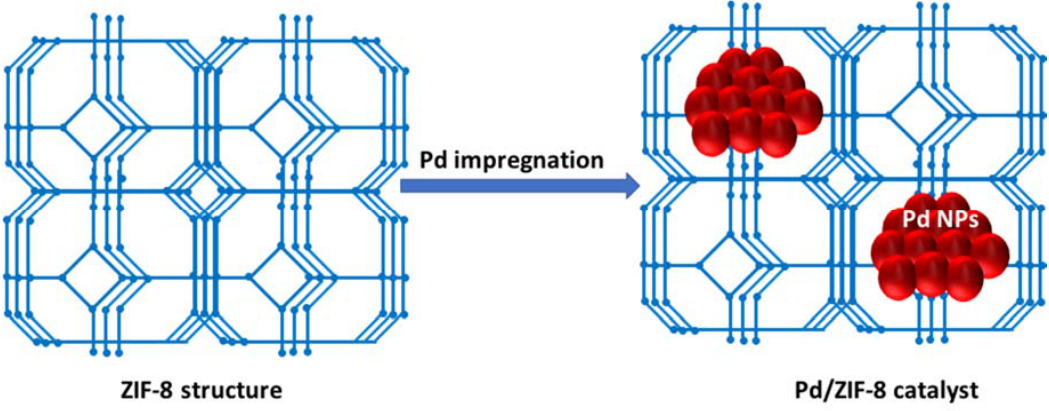
Figure 15. A graphical illustration of the Pd/zeolitic imidazolate (ZIF ‐ 8 catalyst) [88] (Adapted with permission from John Wiley and Sons).